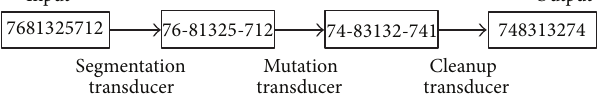
Figure 5: An example of